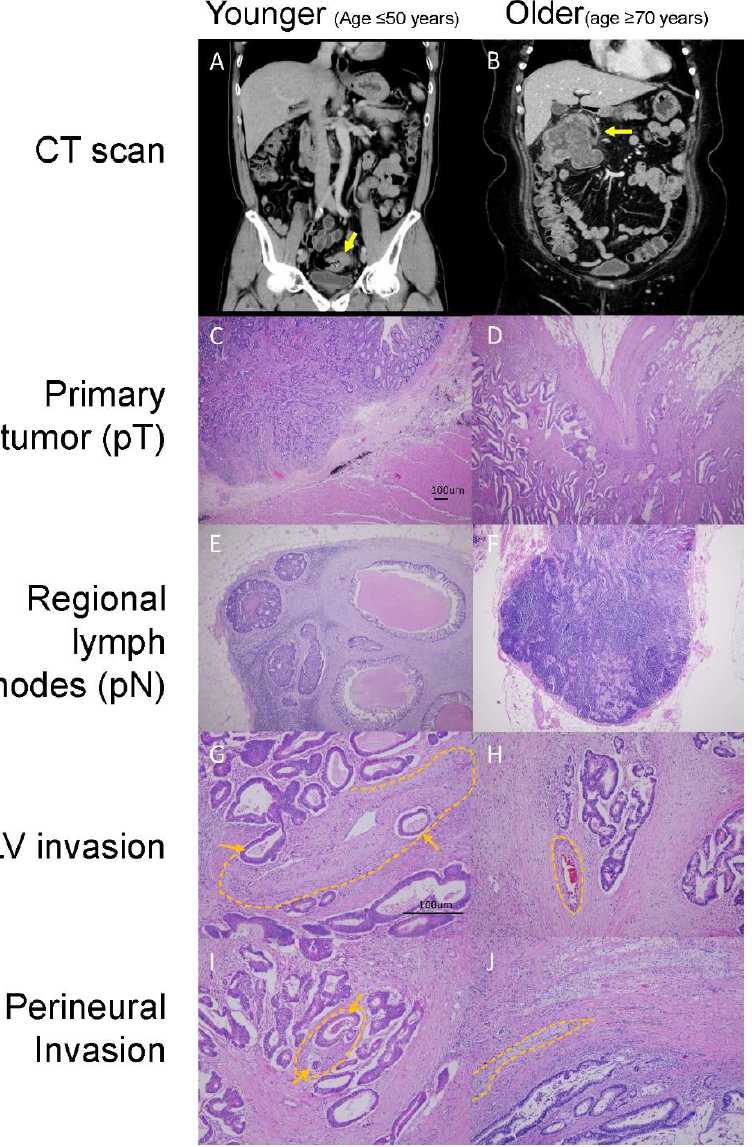
Figure 4. An example of younger (age ≤50 years) and older (age ≥70 years) patients with distinct clinicopathological features present in computed tomography (CT) scans and tumor tissues stained with hematoxylin-eosin. CT scans of a ( A ) younger patient with sigmoid cancer with a size <3 cm and ( B ) an older patient with hepatic flexure colon cancer with a size ≥ 6 cm. Tumor tissues with ( C ) low-depth tumor invasion stage (pT1, 40 × ), ( D ) high-depth tumor invasion stage (pT3, 40 × ), ( E ) positivity for lymph node (LN) metastasis (40 × ) ( F ), no LN metastasis (40 × ), ( G ) positivity for lymphovascular (LV) invasion (100 × ), ( H ) no lymphovascular invasion (100 × ), ( I ) positivity for perineural invasion (100 × ), and ( J ) no perineural invasion (100 × ) are shown. Orange arrows and dotted lines highlight the invasive tumor cells in the vessels and nerves in the figure ( G , I ). The vessels and nerves in ( H , J ) (highlighted by dotted lines) are negative for tumor